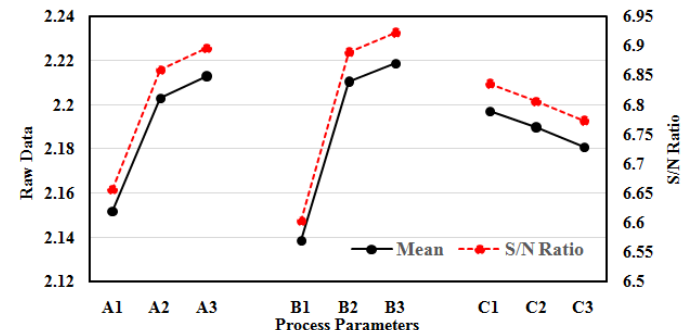
Figure 3. Raw data and S/N ratio plot for MRR.